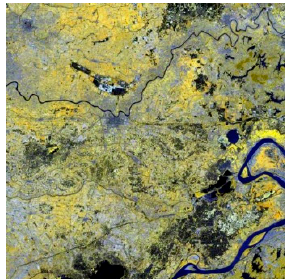
Figure 4. Coverage of the training data.